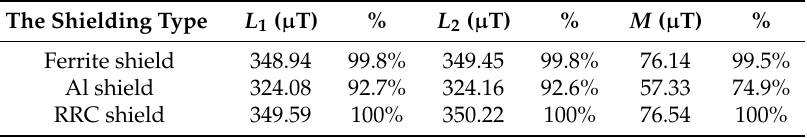
Table 8. The inductances comparison for the proposed causes.